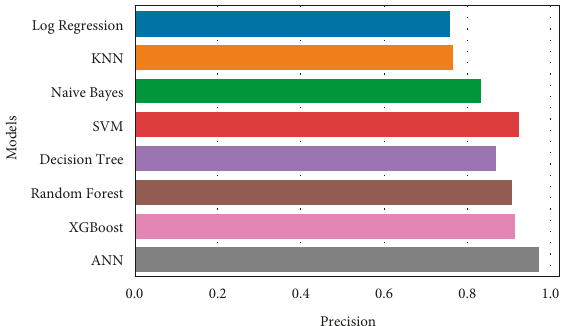
Figure 8: Comparative analysis of precision using different prediction